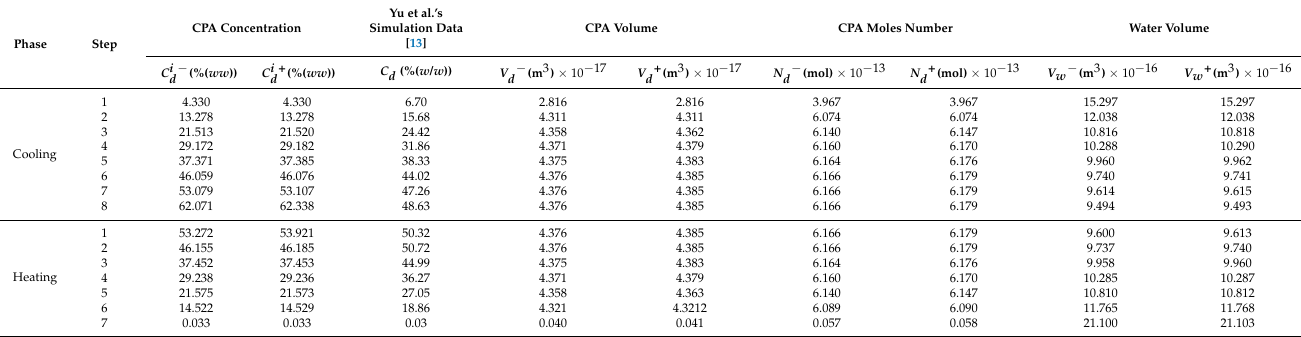
Table 3. Values of intracellular quantities at the end of each step.